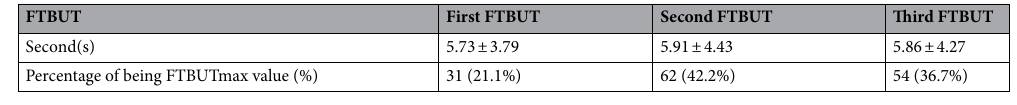
Table 5. Numbers and percentage of each FTBUT reading being the FTBUTmax value. Parameters were presented as mean ±